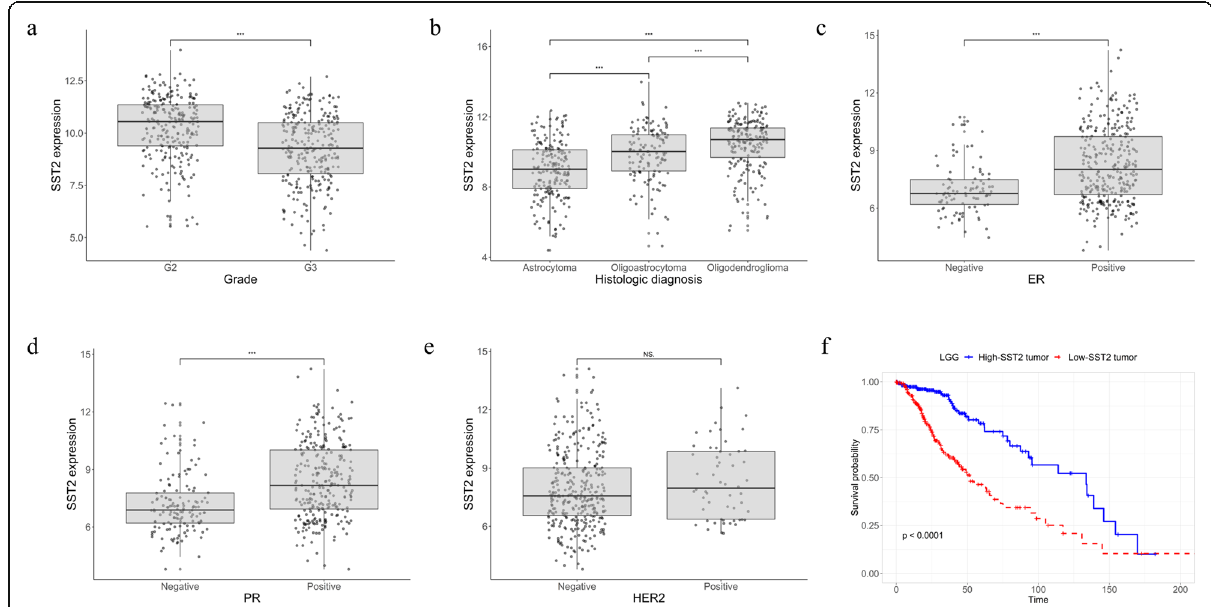
Fig. 4 Association of SST2 with histopathologic findings and prognosis in LGG and BRCA. Three asterisks (***) mean p value lesser than 0.001. NS means no statistical significance ( p > 0.05). SST2 expression level showed significant difference in accordance with histological grade ( a ) and type ( b ) of LGG. SST2 expression level showed significant difference in accordance with hormone receptor status of BRCA ( c , d ). HER2 expression status showed no association with SST2 expression level ( e ). High-SST2 status was significantly associated with a good prognosis in LGG ( p < 0.0001) ( f